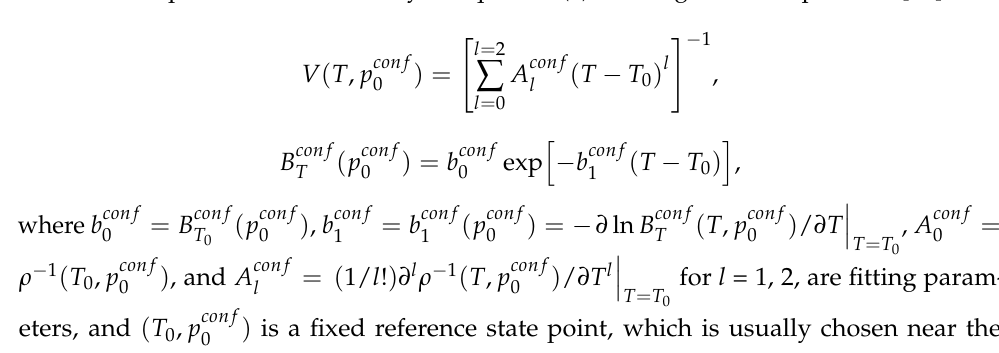
Figure A2. Plots of the isobaric dependences of translational relaxation times τ on the particle number volume V for different anisotropy aspect ratios α r in the supercooled liquid state in the GB model. In the separate panels, there are the cases shown for the different anisotropy aspect ratios α r : ( a ) 1.30, ( b ) 1.35, ( c ) 1.40, and ( d ) 1.45, respectively.